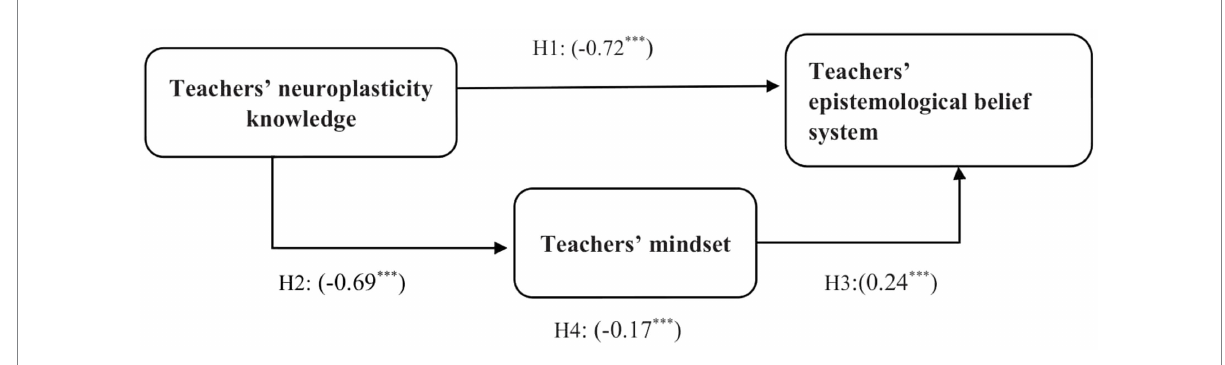
FIGURE 2 The empirical model of teachers’ neuroplasticity knowledge, mindset, and epistemological belief system. ** significant level.